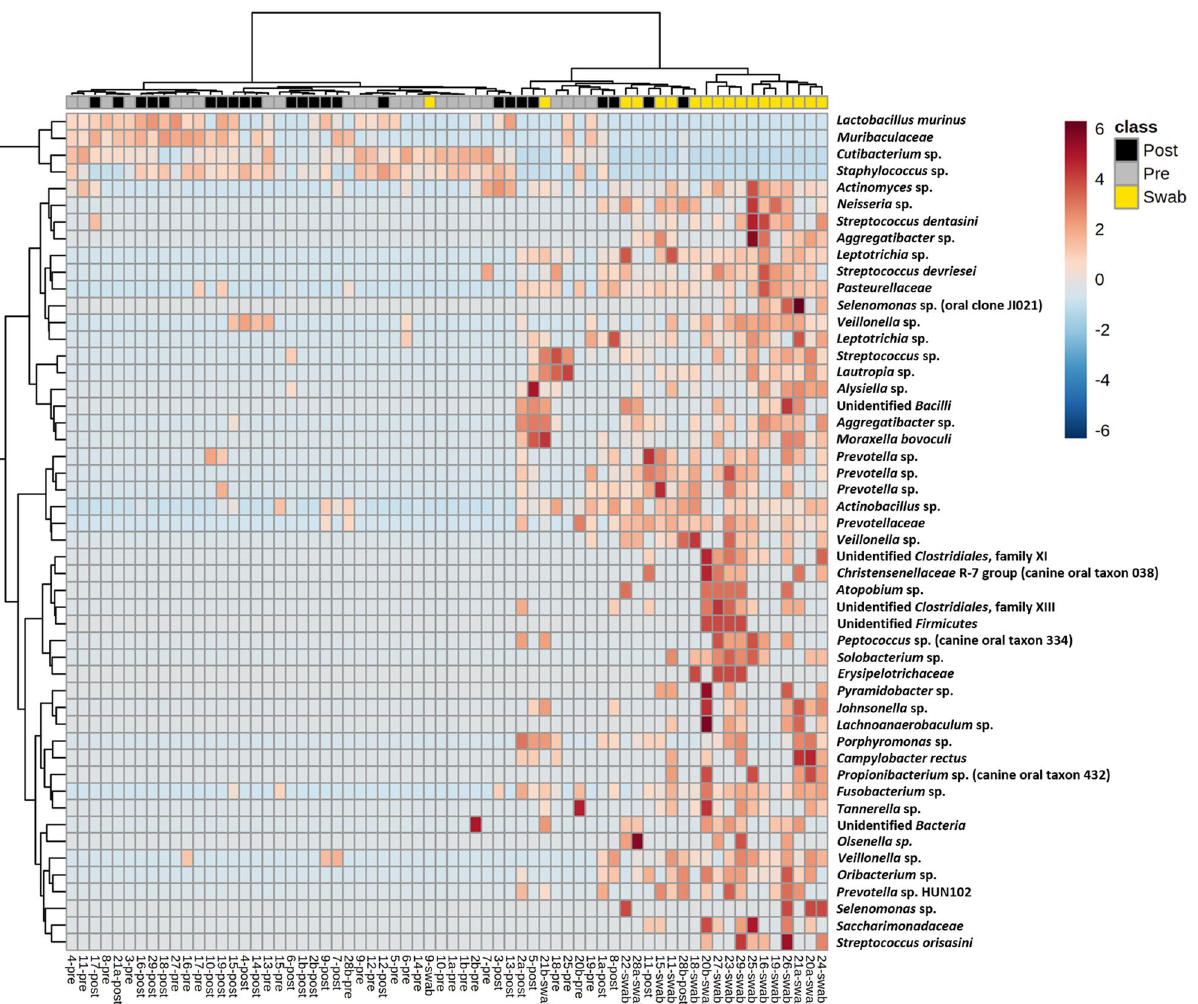
Figure 4. Heatmap generated via hierarchical clustering of samples based on the relative abundance of the 50 ASVs yielding the lowest p values following ANOVA of all ASVs comparing pre- and post- exodontia blood and